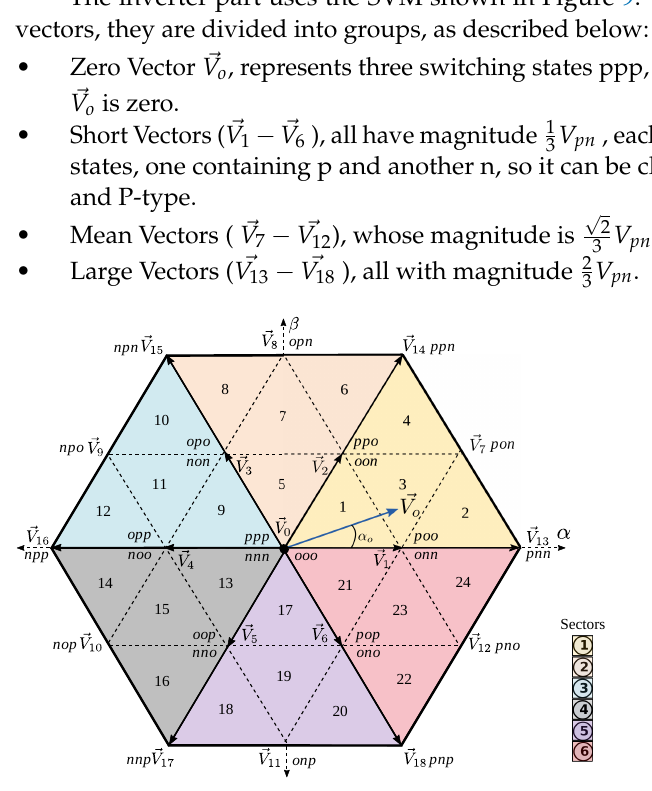
Figure 9. SVM diagram divided into sectors and